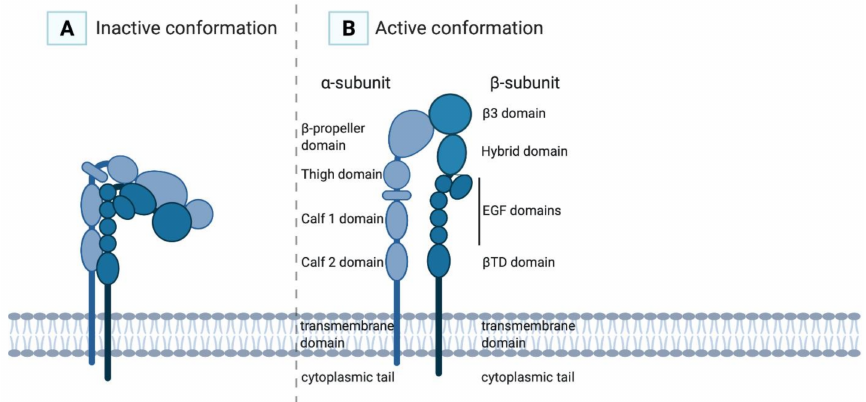
Figure 1. In the inactive conformation of the α IIb β 3 integrin ( A ), the ligand-binding site is poorly accessible for its ligands, while in the active conformation ( B ) the ligand-binding site is exhibited and has high affinity for its